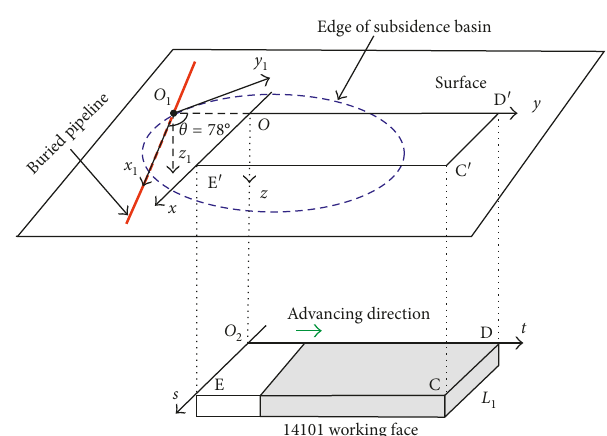
Figure 12: Layout of the 14101 working face and buried